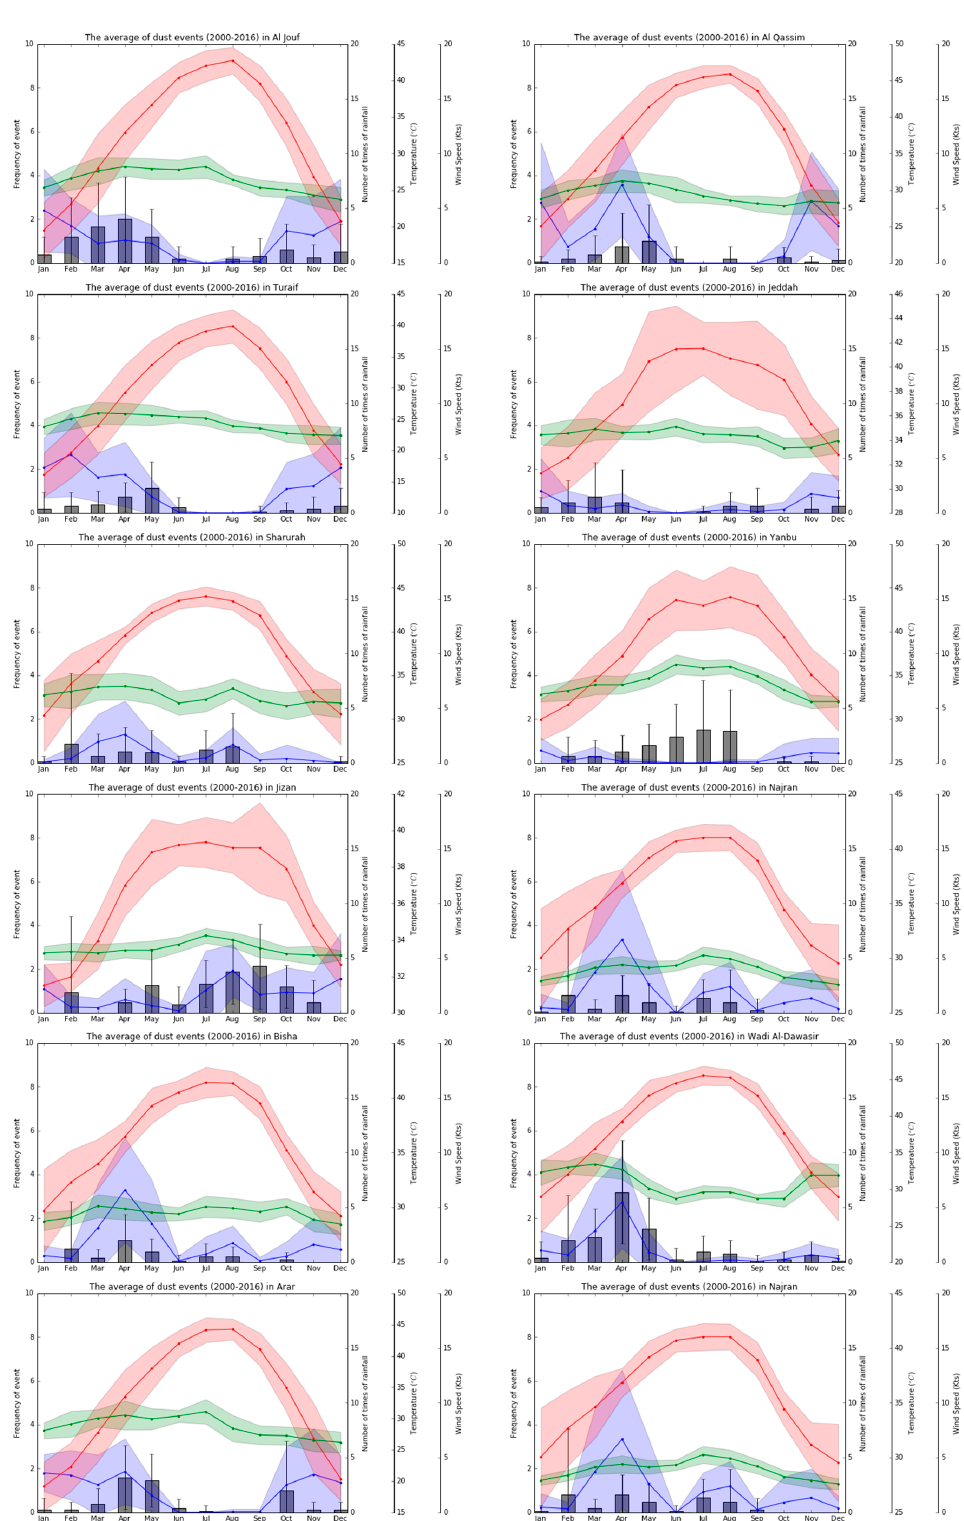
Figure 9. Scatter plots showing the total annual number of dust storm events per PME station between the years 2000 and 2016, including a five-pass filter and linear regression line with associated model error bounds (at 95% confidence interval).